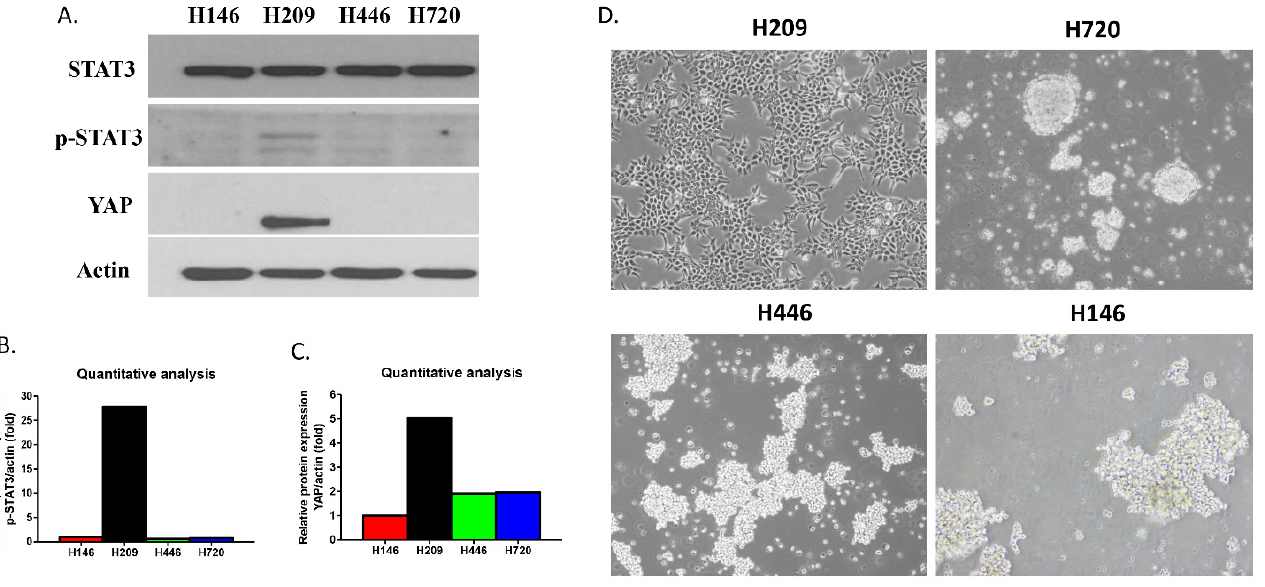
Figure 1. STAT3, p-STAT3 and YAP protein expression and morphology in human small cell lung cancer (SCLC) cell lines. ( A ) STAT3, p-STAT3 and YAP protein expression in SCLC cell lines. ( B , C ) Quantitative analysis of p-STAT3 and YAP protein expression in SCLC cell lines. ( D ) Morphology of SCLC cell lines.